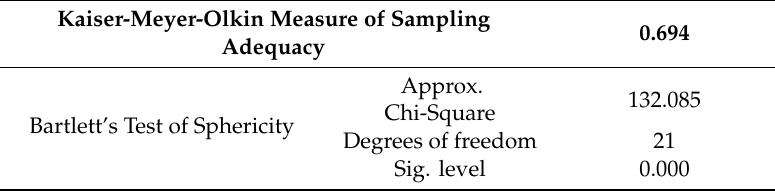
Table 5. KMO test of sampling adequacy and Bartlett’s test of sphericity.